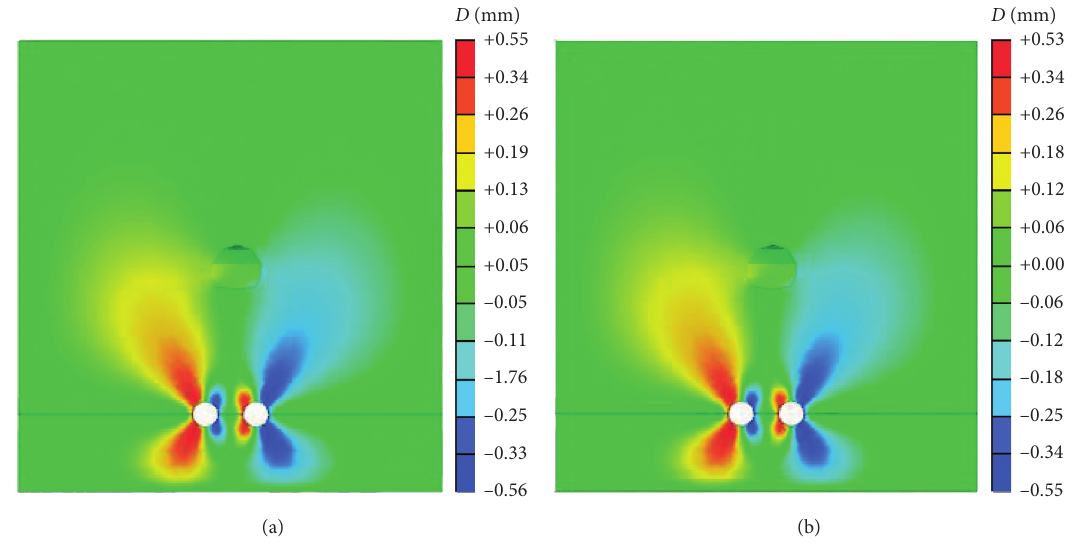
Figure 10: Cloud diagram of horizontal deformation of the newly built tunnel. (a) Excavation program I. (b) Excavation program II.